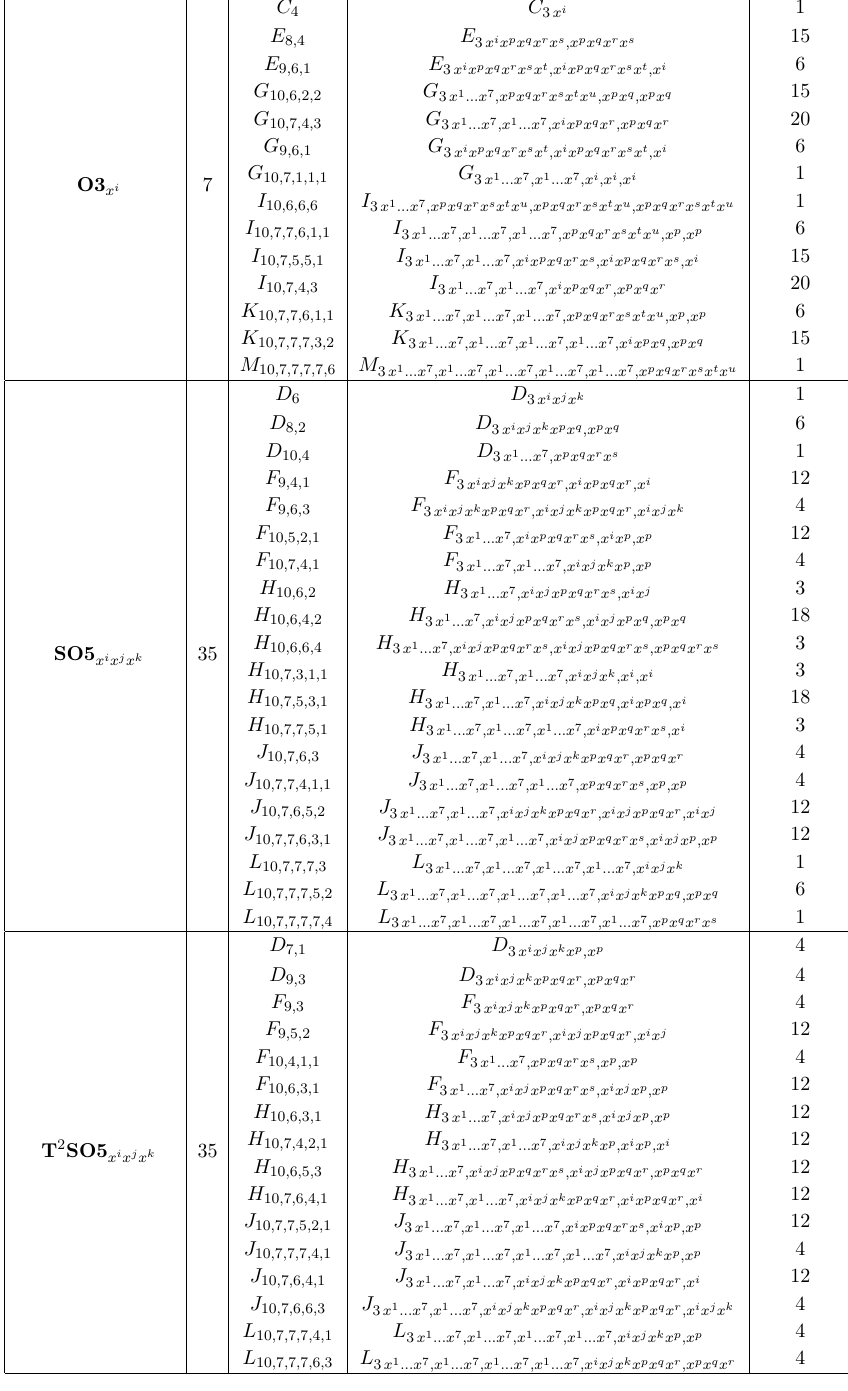
Table 10 . (Part 2 of 2) The Z 2 truncations of the maximal theory in D =